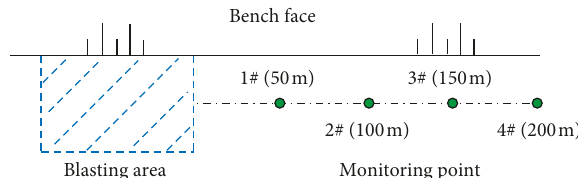
Figure 4: Diagram for location of blasting vibration monitoring.